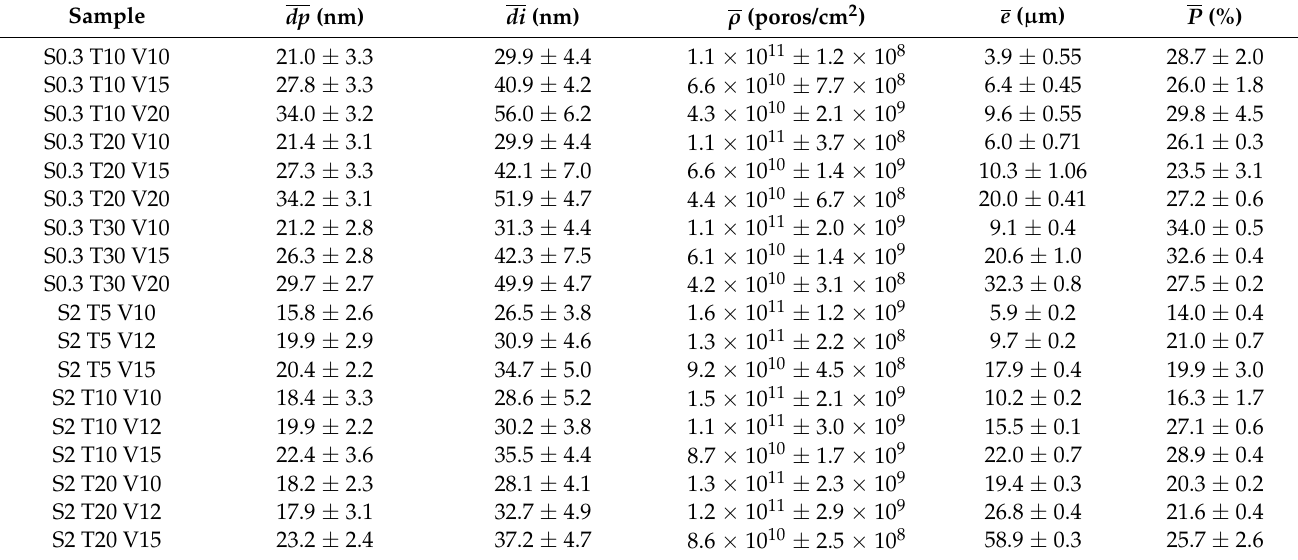
Table 2. Average values of the morphological parameters of Anodic aluminium oxide (AAO) nanostructured coatings obtained in sulphuric acid as a function of concentration, temperature, and anodization voltage. The test pieces were named as follows: the letter S followed by a number, corresponding to the sulphuric acid and the value of the concentration in Molar; the letter T and the value of the electrolyte temperature in °C and the letter V together with the voltage value in volts. For example, S0.3 T10 V10 corresponds to an anodized test piece with two equal steps in 0.3 M sulphuric acid at 10 °C and 10 V.